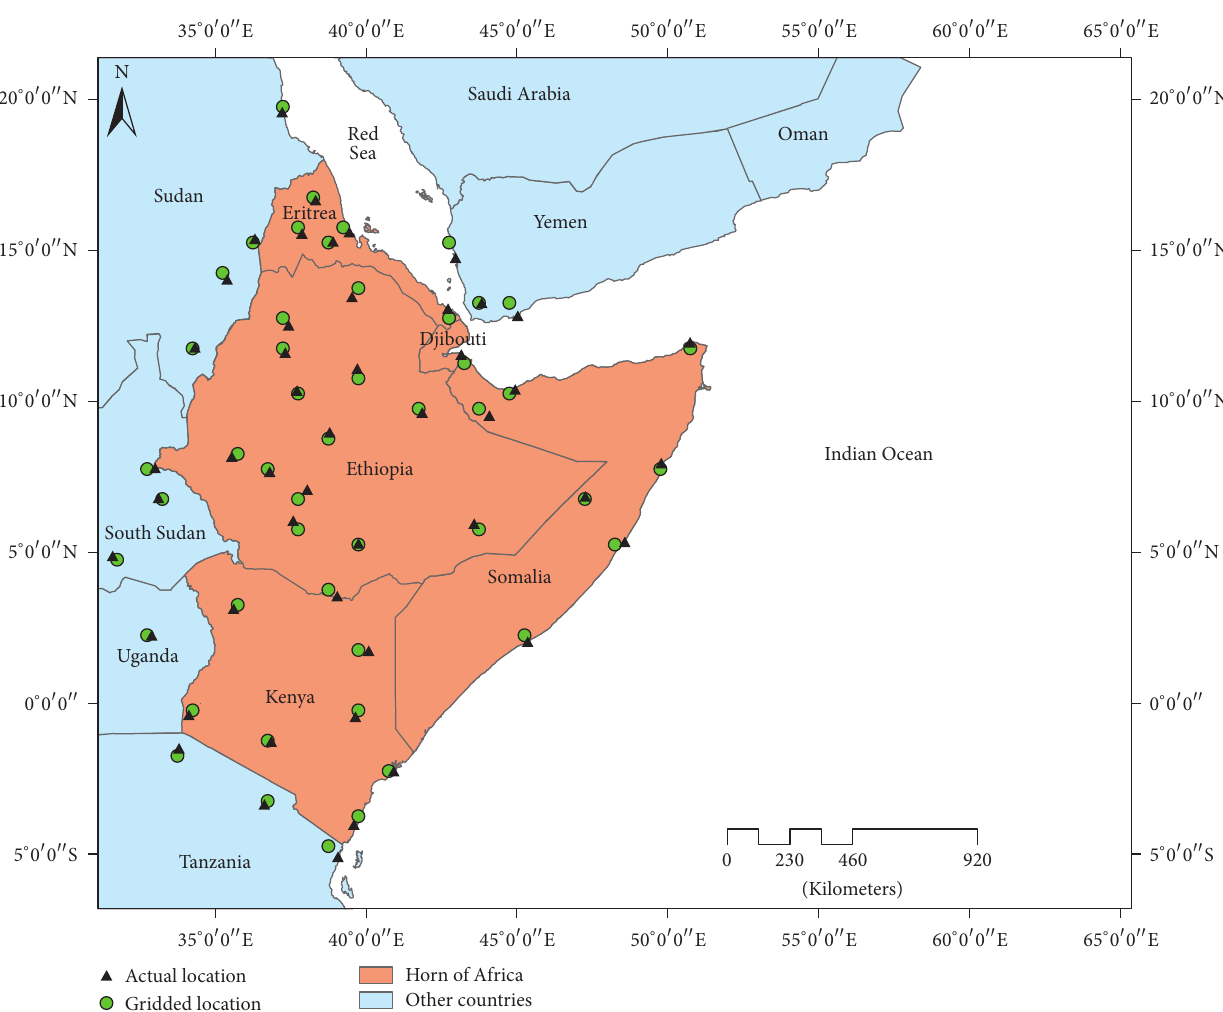
Figure 1: The selected locations of actual and gridded meteorological stations in the